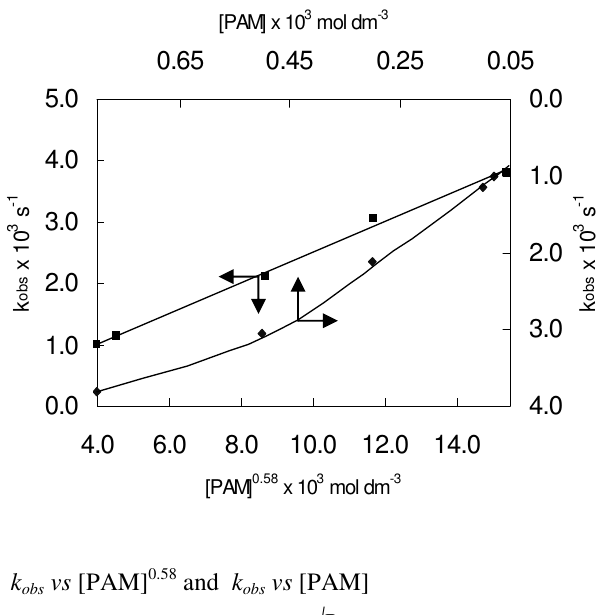
vs [PAM] 0.58 and k obs